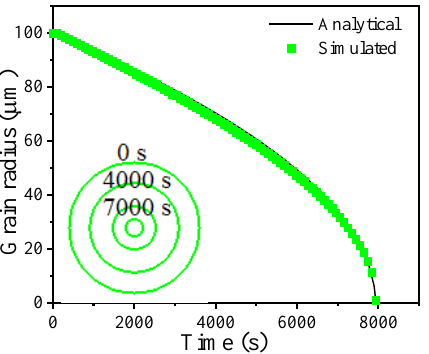
Figure 8. Comparison between analytical and simulated results for circular grain shrinkage.